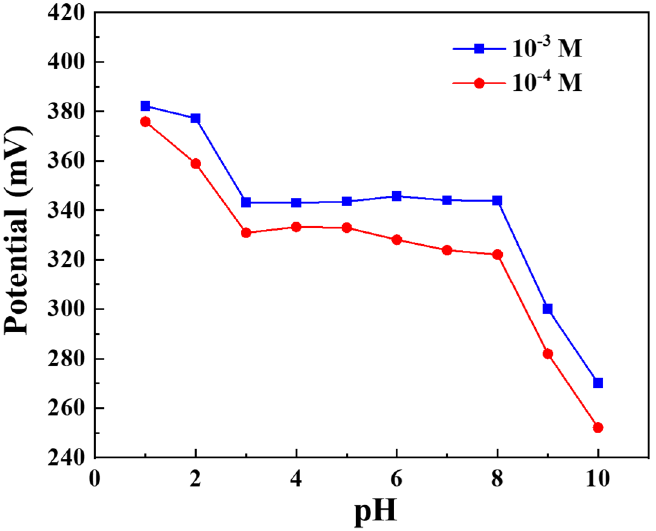
Figure 9. Effect of pH on the NO 3 − -ISM/Co 3 O 4 NPs/SPE potential